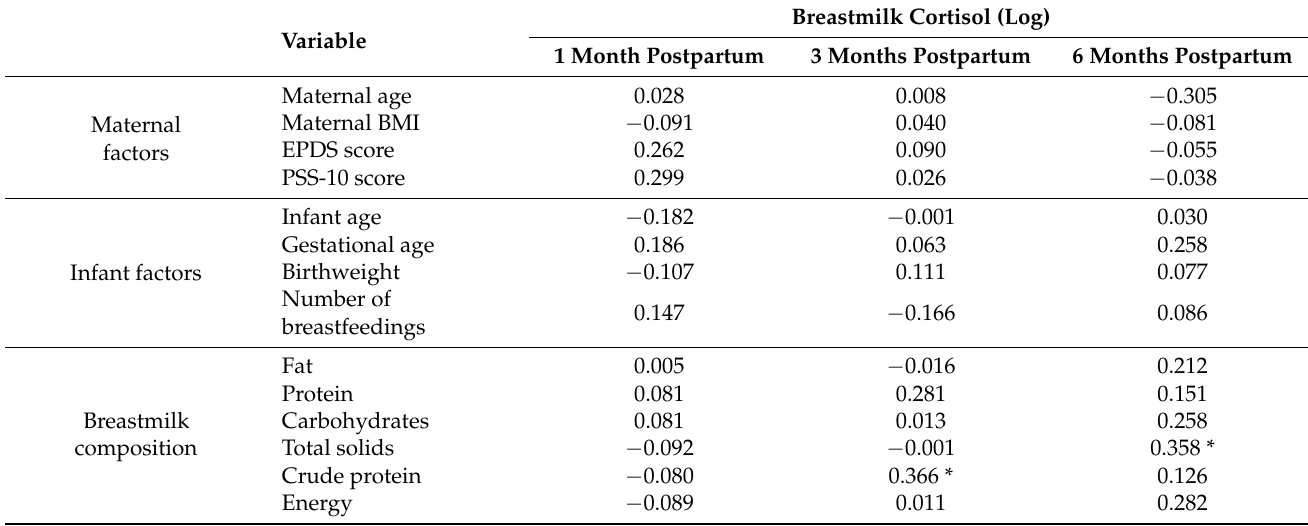
Table 3. Partial correlations between breastmilk cortisol (log), maternal and infant factors, and breastmilk macronutrient composition, adjusted for season of breastmilk sample collection.